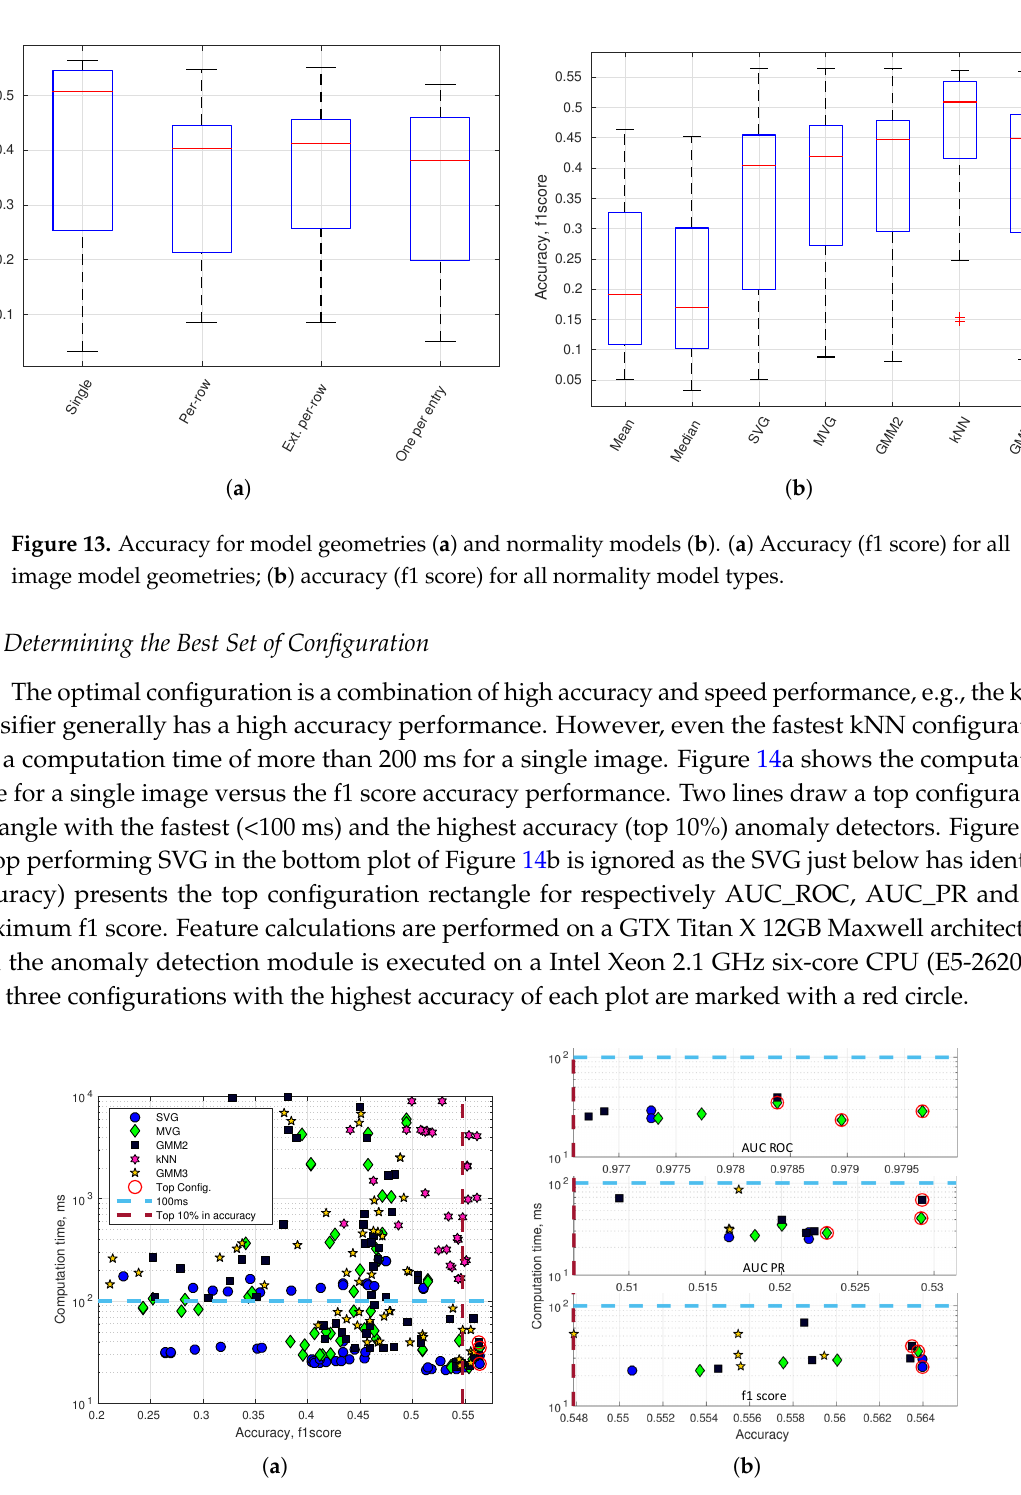
Figure 14. Accuracy and computation time. ( a ) Accuracy is measured using the f1 score; ( b ) top configurations rectangle of AUC_ROC, AUC_PR and the max f1